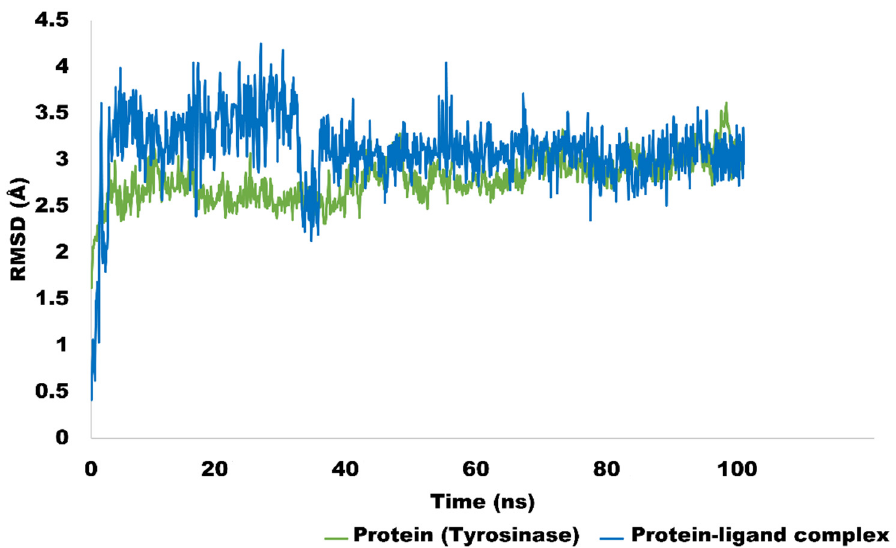
Figure 13. Evolution of RMSD pattern of enzyme tyrosinase (green-coloured trajectory) and protein–ligand complex (blue-coloured trajectory).